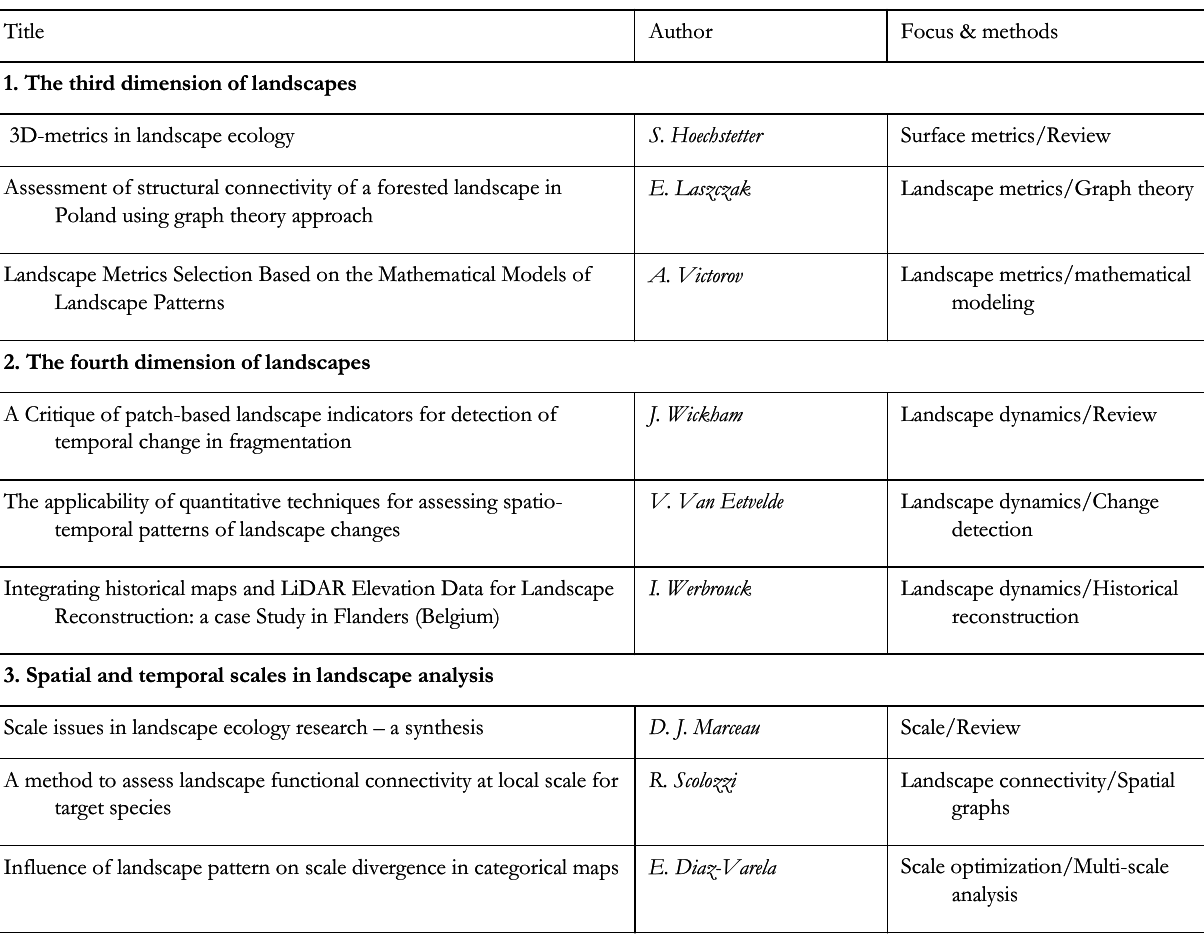
Table 1. Lectures within the Symposium 6: The third and fourth dimensions of landscapes. IALE European Conference, Salzburg,